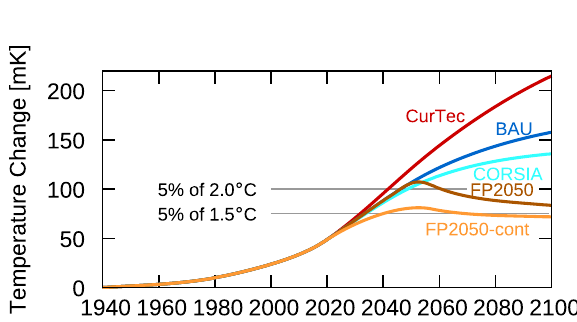
Fig. 2 Near-surface temperature change of fi ve scenarios including CO 2 and non-CO 2 -effects. The horizontal lines indicate 5% of a 2 °C and 1.5